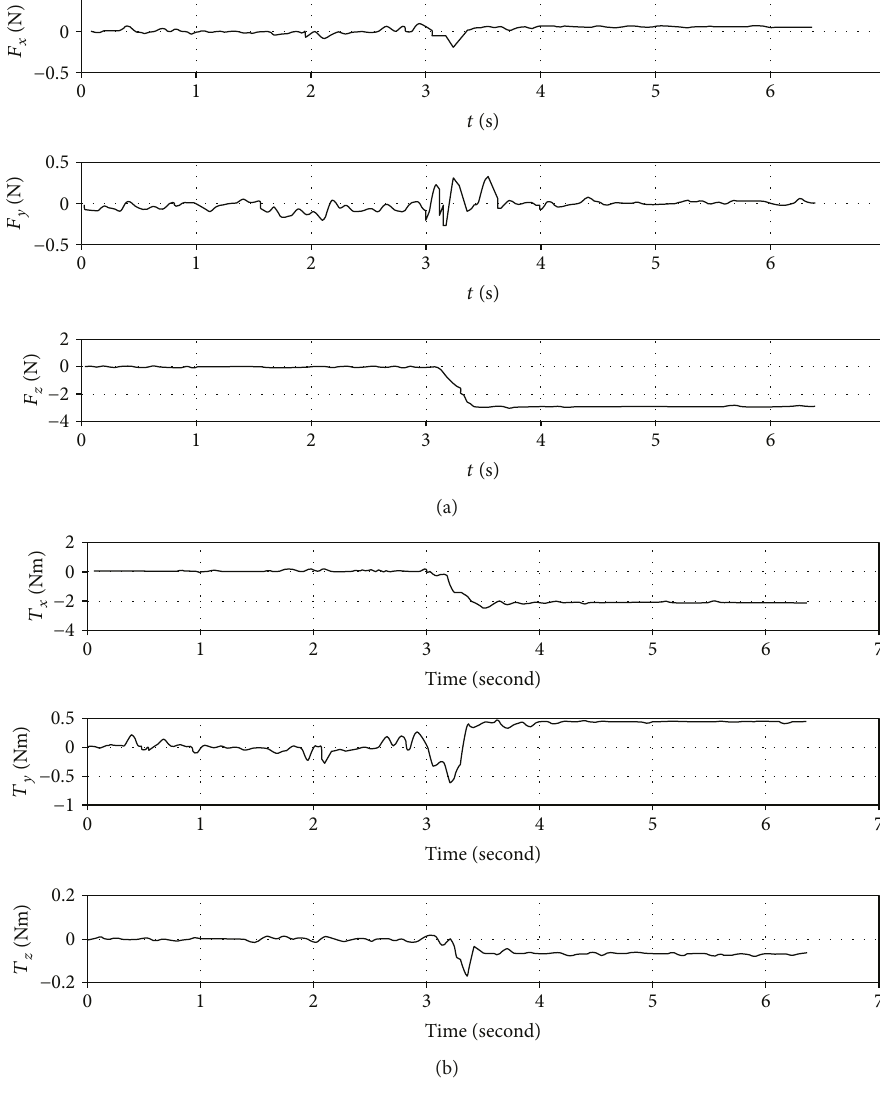
Figure 20: End force and moment under impedance control: (a) force and (b)